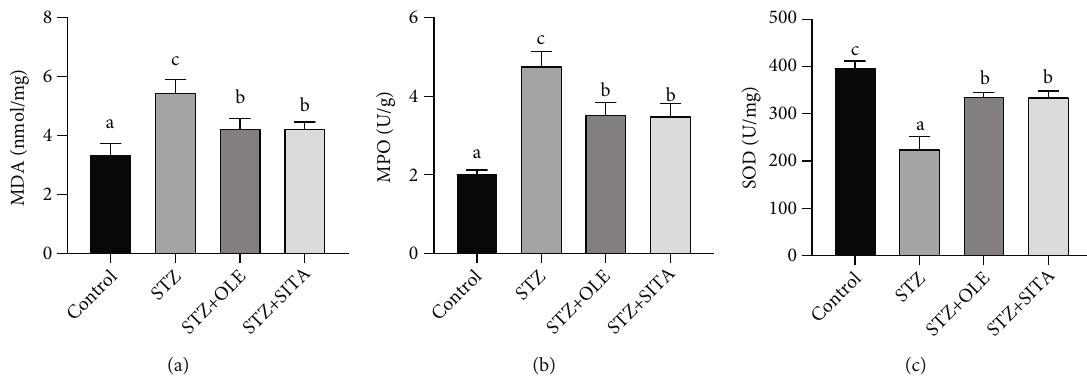
Figure 3: The e ff ect of oleuropein on oxidative stress in the hippocampus tissue of diabetic rats. Blood biochemical analysis showed MDA (a), MPD (b), and SOD (c) levels in hippocampus tissue of rats in each group. MDA: malondialdehyde; MPO: myeloperoxidase; SOD: superoxide dismutase. Each set contains data from 3 samples tested independently; LSD test was used for multiple comparisons. ∗∗ p < 0 : 05 vs. control group and ## p < 0 : 05 vs. STZ group.